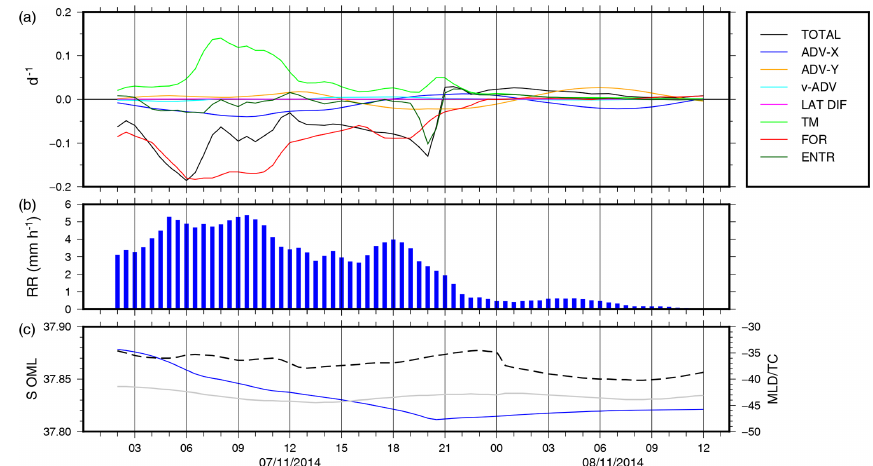
Figure 10. Time series of the different components of the tendency in the evolution of the salinity in the OML and in the SFA ( a , colours), of the instantaneous rain rate ( b , blue), and of the time evolution of the salinity in the OML, MLD (dashed black), and T − 10m –0.3 ◦ C thermocline (grey) in the SFA (c) .